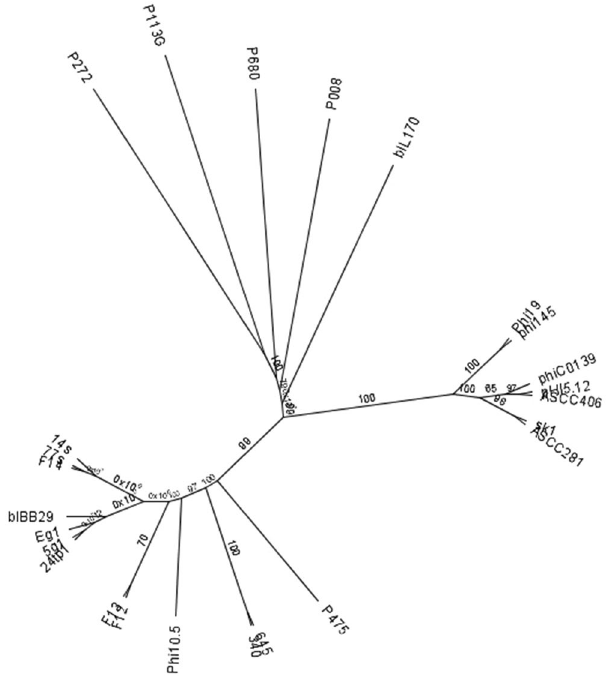
Figure 7. Maximum-likelihood phylogenetic tree of Lactococcus phages sequenced in this study. Phage phylogenies were reconstructed from multiple alignment of 936-type phage whole genome sequences generated using MUSCLE with 8 iterations (default settings). A maximum-likelihood tree was constructed using PHYML and the Junker-Castor substitution model with 100 bootstrap resamplings. Consensus support (%) is marked at each